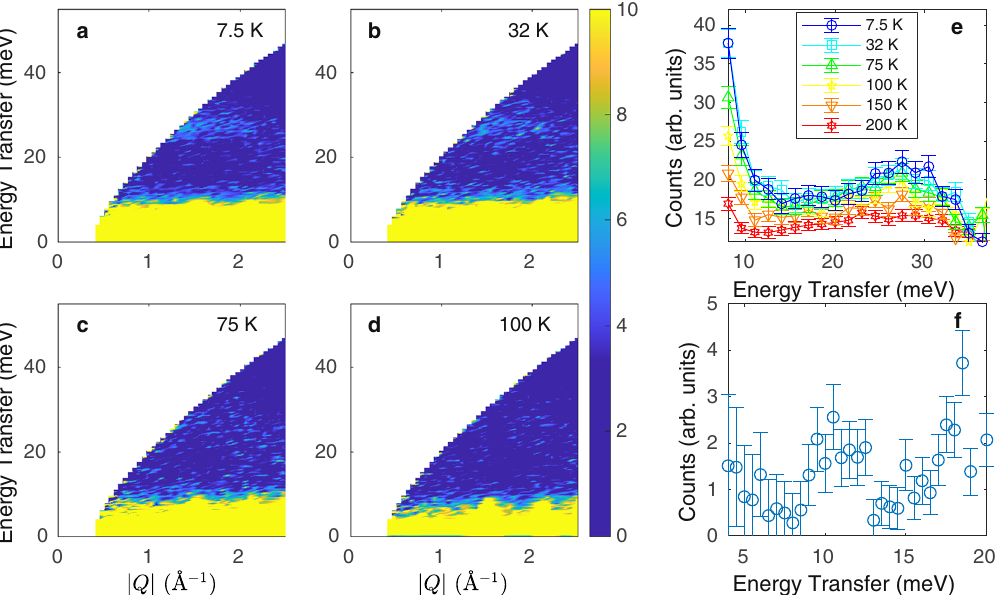
Fig. 5 Inelastic neutron scattering of Ba 2 LuMoO 6 . Inelastic neutron scattering intensity maps measured with E i = 70 meV at a 7.5 K, b 32 K, c 75 K and d 100 K as function of energy transfer and | Q |, corrected for background by subtracting Bose-factor corrected 200 K data. A weakly dispersing, gapped singlet-triplet excitation is observed at 28 meV in the 7.5 K and 32 K data. At higher temperatures singlets are no longer observed. e Cuts of the E i = 70 meV Bose-factor corrected inelastic neutron scattering data showing the integrated intensity for 0 < | Q | < 2 Å − 1 as function of energy transfer. The singlet-triplet excitation centered at 28 meV decreases in intensity with increasing temperature, but no other features are observed. f Cut of Bose-factor corrected 7.5 K E i = 30 meV data minus the Bose-factor corrected 200 K E i = 30 meV data showing additional excitation features at 11 and 17 meV. Error bars represent one standard